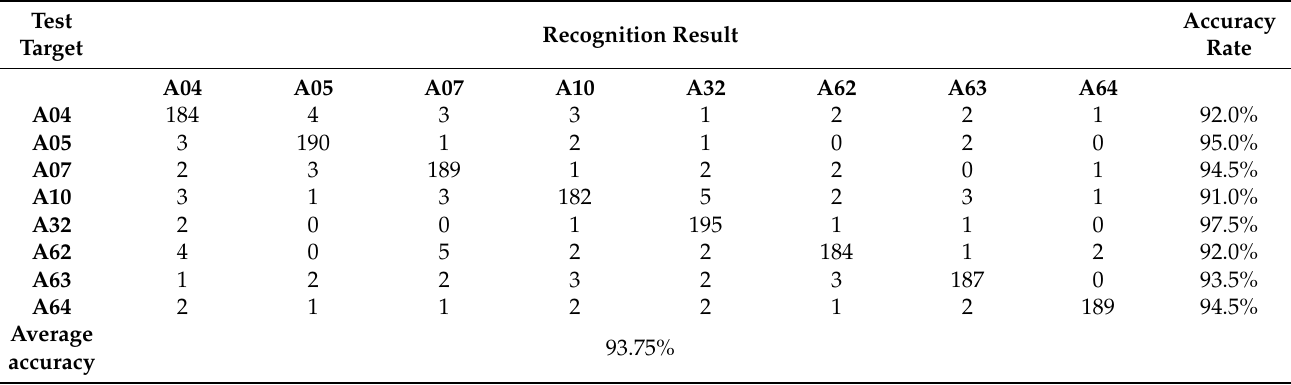
Table 5. Target recognition results (T72 dataset).